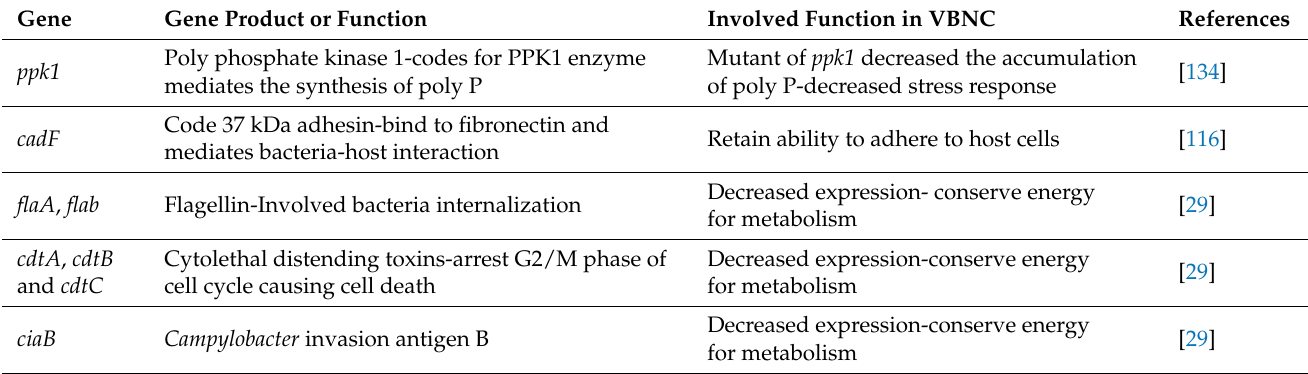
Table 5. Cluster of genes involved and its function in VBNC formation in Campylobacter jejuni